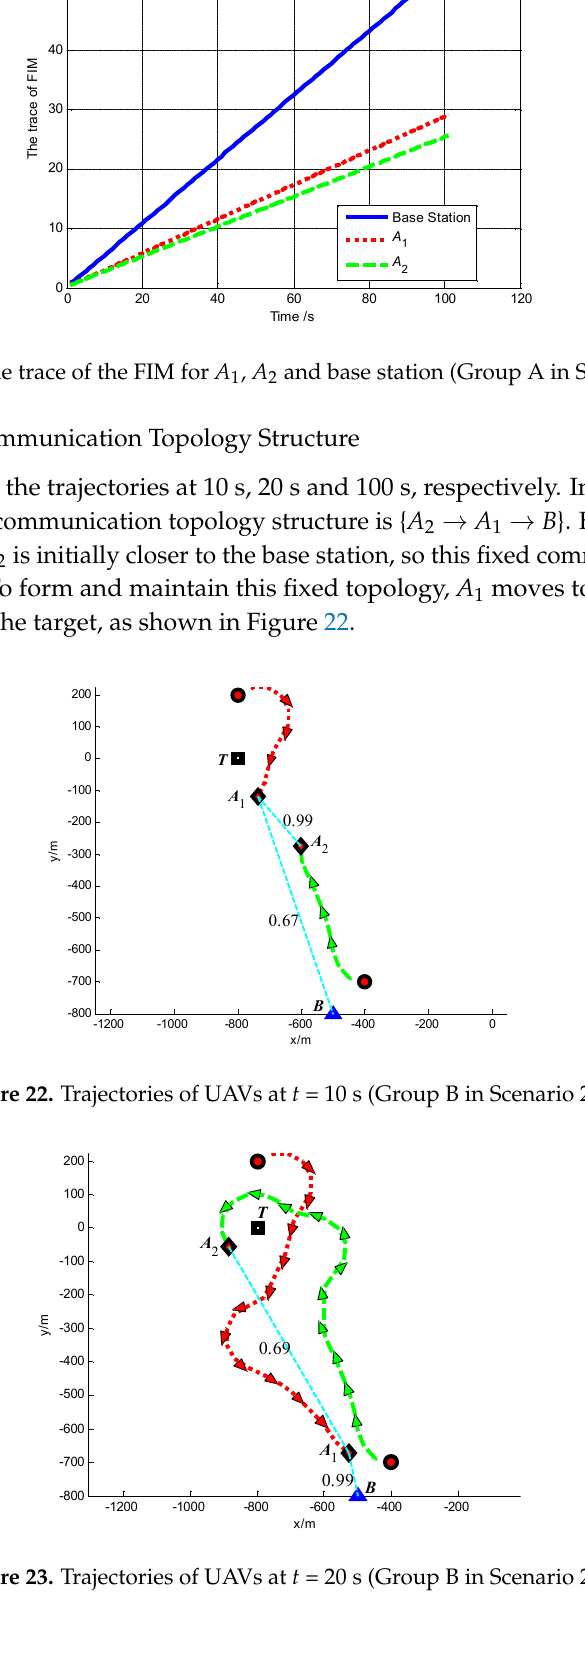
Figure 20. The probabilities of successful transmission of A 1 and A 2 to base station (Group A in Scenario 2).